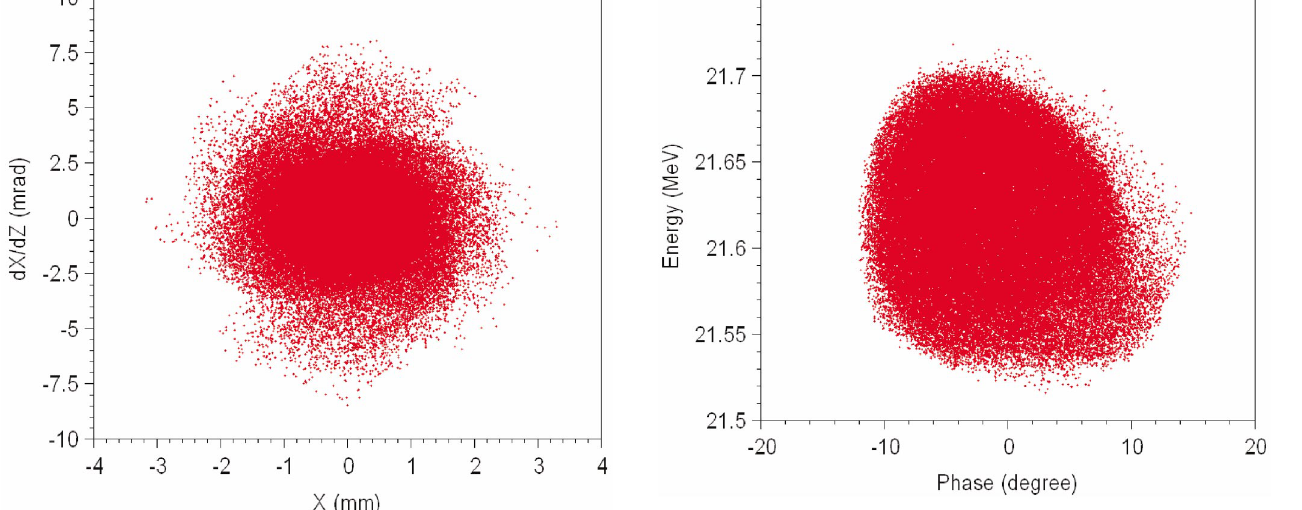
FIG. 30. (Color) Phase portrait in the horizontal plane at the linear accelerator exit.